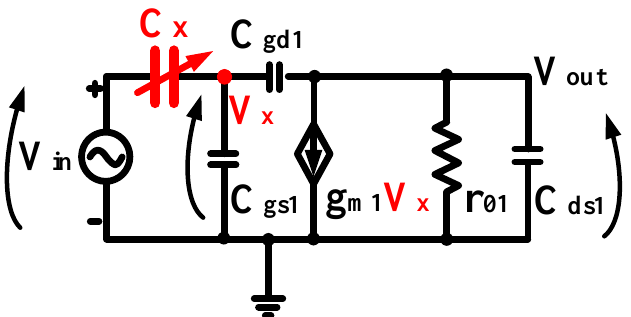
Figure A1. Small-signal equivalent circuit with asymmetric capacitor C x .